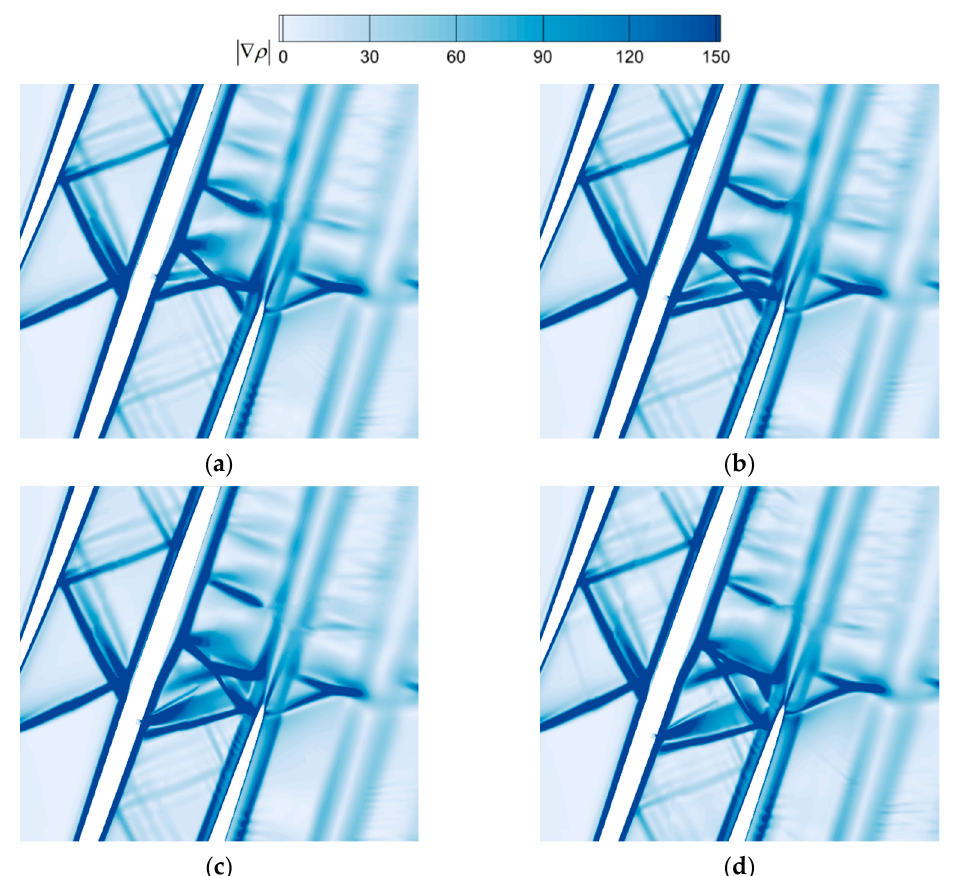
Figure 12. Density gradient magnitude contours with different locations of jet: ( a ) Δ𝑙 = 2𝛿 ; ( b ) Δ𝑙 = 5𝛿 ; ( c ) Δ𝑙 = 8𝛿 ; ( d ) Δ𝑙 = 10𝛿 .